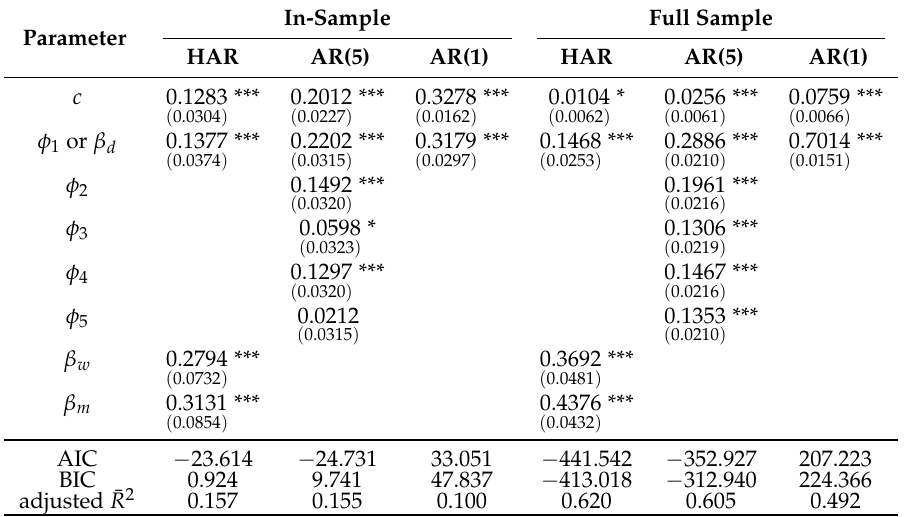
The corresponding p -values are reported in parentheses.